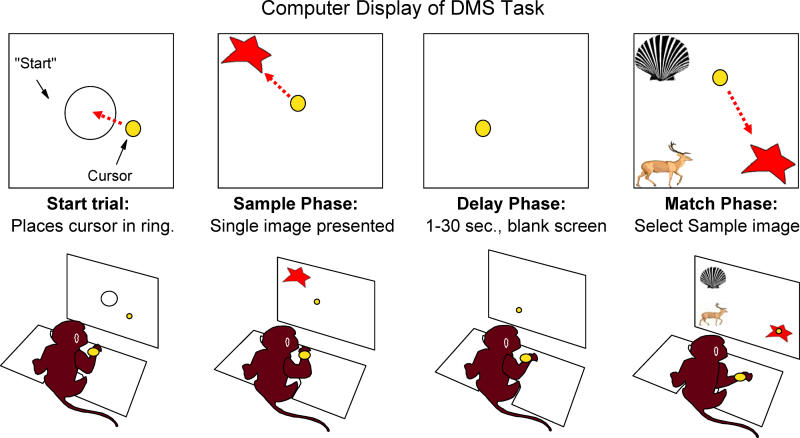
Multi-Image Visual DMS TaskDMS trials consist of four phases. In the first, the start-trial phase, a circle was displayed to initiate the trial. The monkey had to move the cursor into the circle to initiate presentation of the sample image. Next, in the sample phase, a single “sample” clip art image (red star) was presented. Movement of the cursor into the sample image blanked the screen and initiated the delay phase. In this third phase, delay, the screen was blanked for a 1–30 s interval (randomly selected on each trial); the match phase was initiated automatically at the end of delay phase. In the last, match phase, the sample image was presented simultaneously with one to five other randomly chosen “nonmatch” images. Images could appear randomly at any of nine spatially distinct screen locations. The sample image always appeared at a different location in the match phase, and monkeys were required to place the cursor in the sample image for 200 ms or longer to be rewarded and terminate the trial. Movement of cursor into a nonmatch image for 200 ms or longer terminated the trial with no reward. Each clip-art image (including samples and nonmatches) was selected from a list of 5,000 clip art images and presented only once, such that all trials were unique with no repetition of images during the session. The intertrial interval was 10 s, in which the screen was blank prior to the appearance of the start-trial circle.DOI: 10.1371/journal.pbio.0030299g001